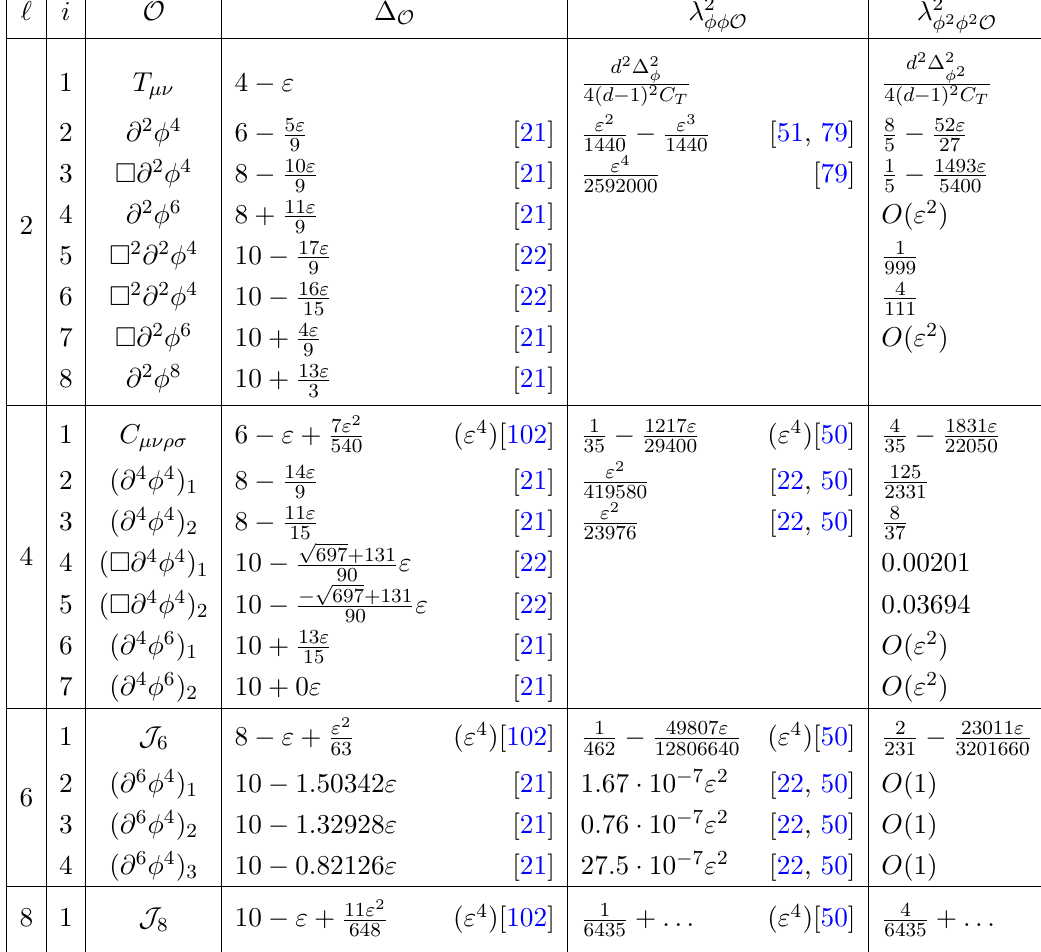
Table 4 . Perturbative results for Z 2 -even operators with ∆ 6 10 of even spin ‘ > 0 . The OPE coefficients λ 2 can all be extracted from the correlator given in [74], see also [22, 79] For λ 2 φ 2 φ 2 O with ‘ = 4 , 6 , . . . , order (cid:15) 2 results are also available in [79]. For entries that are empty, it is not known to what order in ε the OPE coefficients